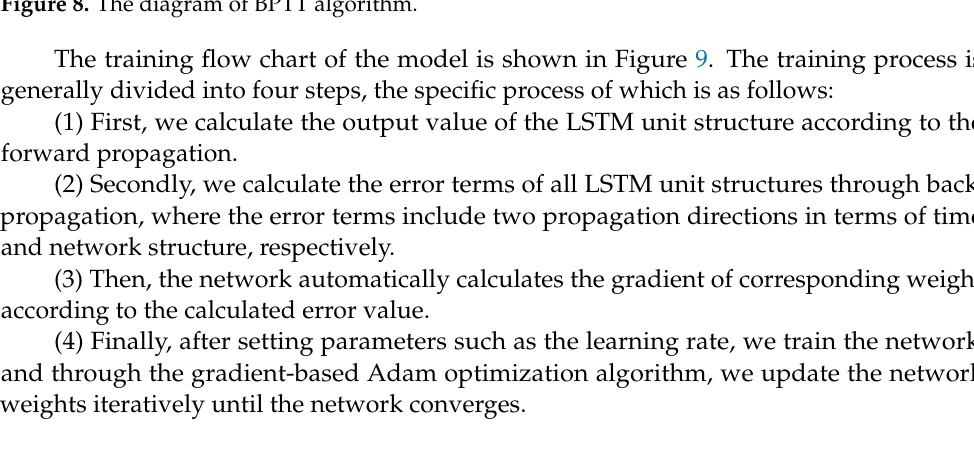
Figure 8. The diagram of BPTT